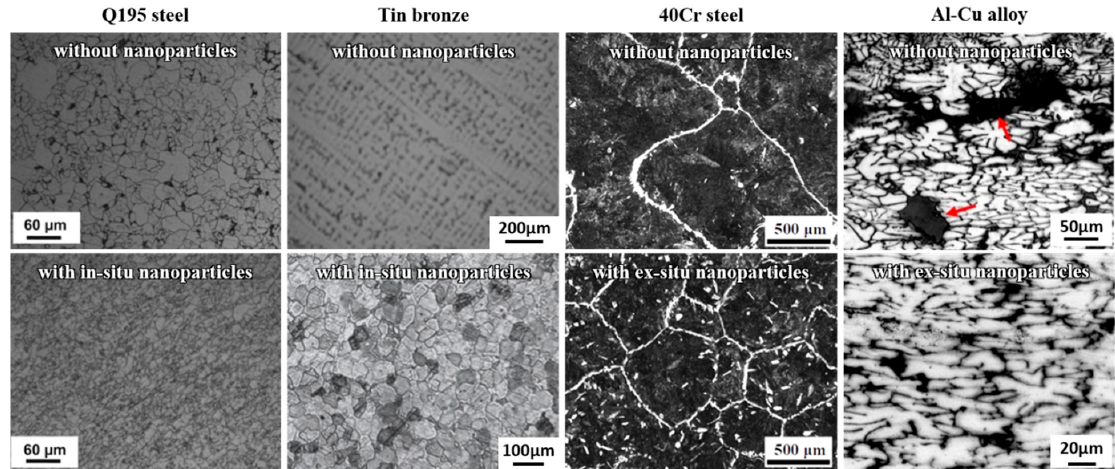
Figure 6. Grain refinement effect caused by nanoparticles in hot rolled Q195 steel, reprinted with permission from ref. [64]. 2022, Elsevie.; tin bronze, reprinted with permission from ref. [77]. 2022, Elsevie; 40Cr steel, reprinted with permission from ref. [48]. 2022, Elsevier, and Al-Cu alloy (The discontinuous black areas marked with red arrows are macro-segregation), reprinted with permission from ref. [4]. 2022, Elsevier.